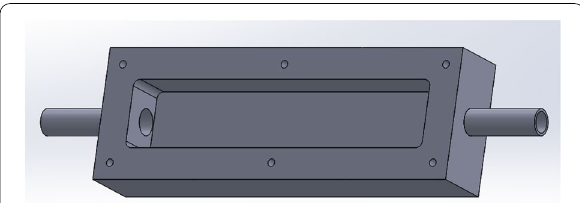
Fig. 1 Schematic of a custom-made flow chamber to hold coupons (inner dimensions: 12.0 cm H